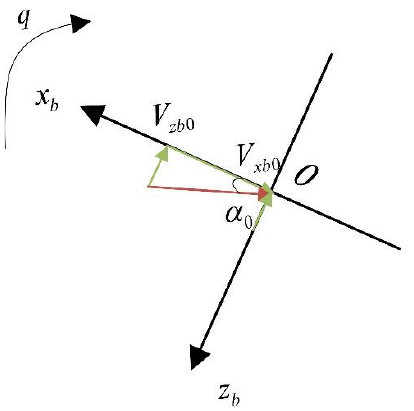
Figure 2. Motion and velocity in the longitudinal plane of the aircraft.